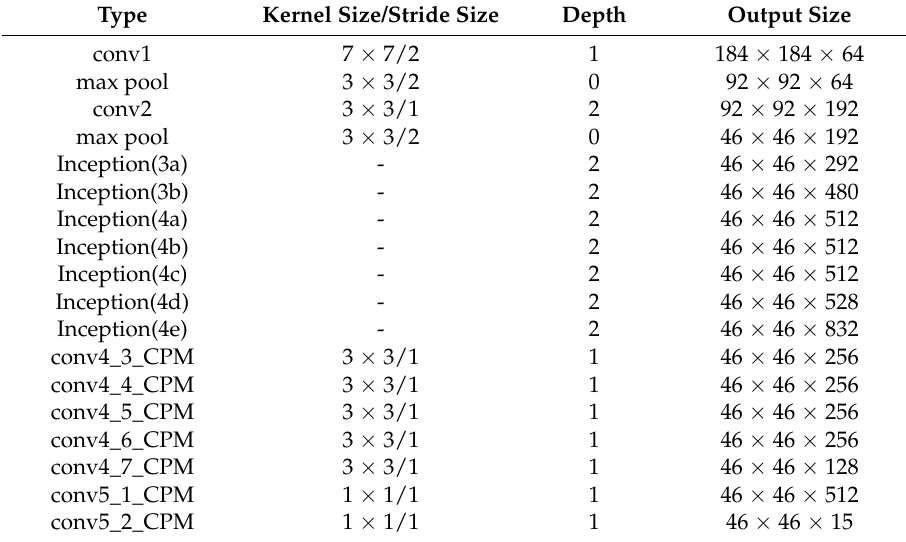
Table 1. The main data change of the stage 1 network.